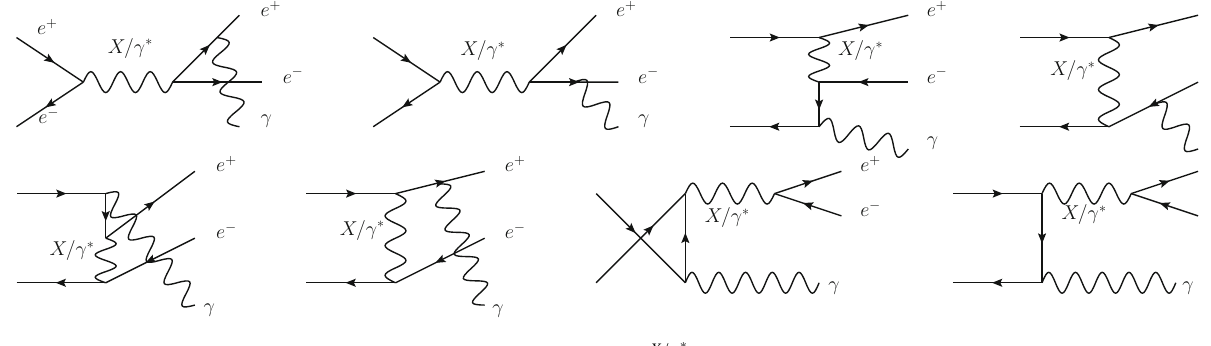
Fig. 3 The Feynman diagrmas for the signal/background processes e + e −